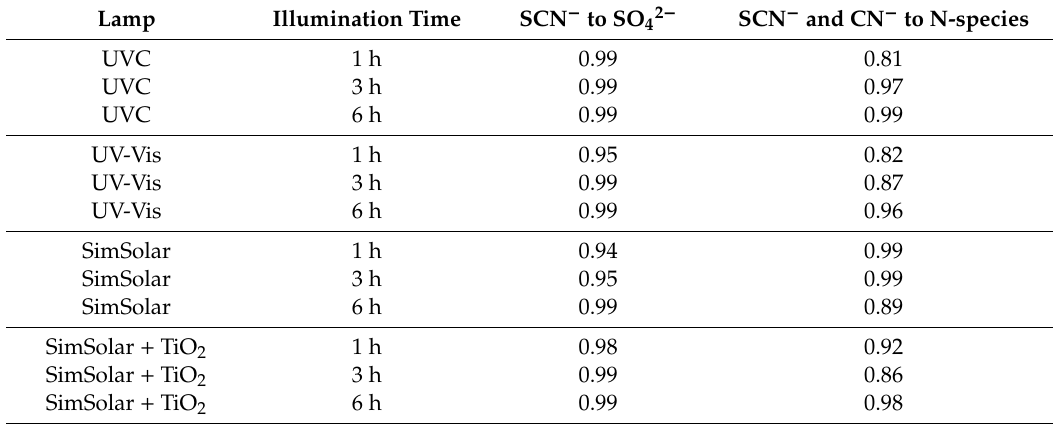
Table 3. Molar yields of thiocyanate (SCN − ) and cyanide (CN − ) conversion to the intermediates detected in the solution (sulphates and N-containing species) after various illumination periods. Lamp Illumination Time SCN − to SO 42 − SCN − and CN − to N-species UVC 1 h 0.99 0.81 UVC 3 h 0.99 0.97 UVC 6 h 0.99 0.99 UV-Vis 1 h 0.95 0.82 UV-Vis 3 h 0.99 0.87 UV-Vis 6 h 0.99 0.96 SimSolar 1 h 0.94 0.99 SimSolar 3 h 0.95 0.99 SimSolar 6 h 0.99 0.89 SimSolar + TiO 2 1 h 0.98 0.92 SimSolar + TiO 2 3 h 0.99 0.86 SimSolar + TiO 2 6 h 0.99